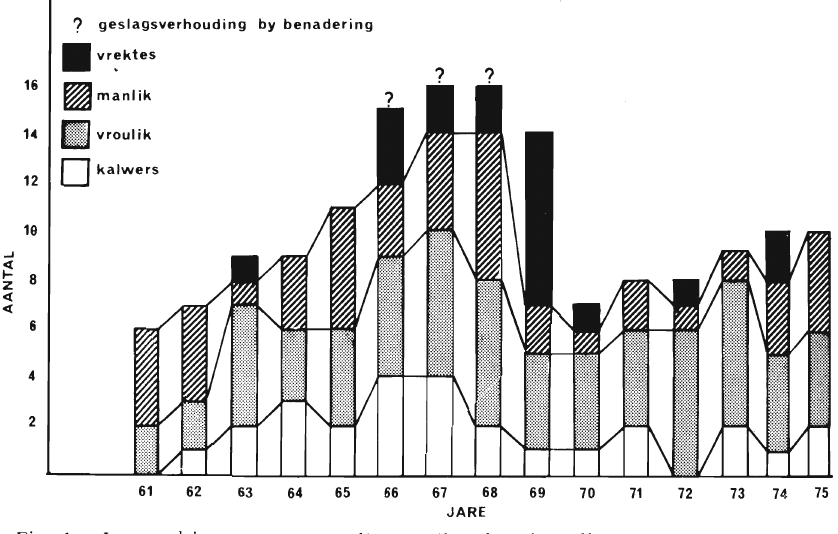
Lewenshistogram van die rooihartbeesbevolking in die Bontebok Nasionale Park vanaf 1961-1975.